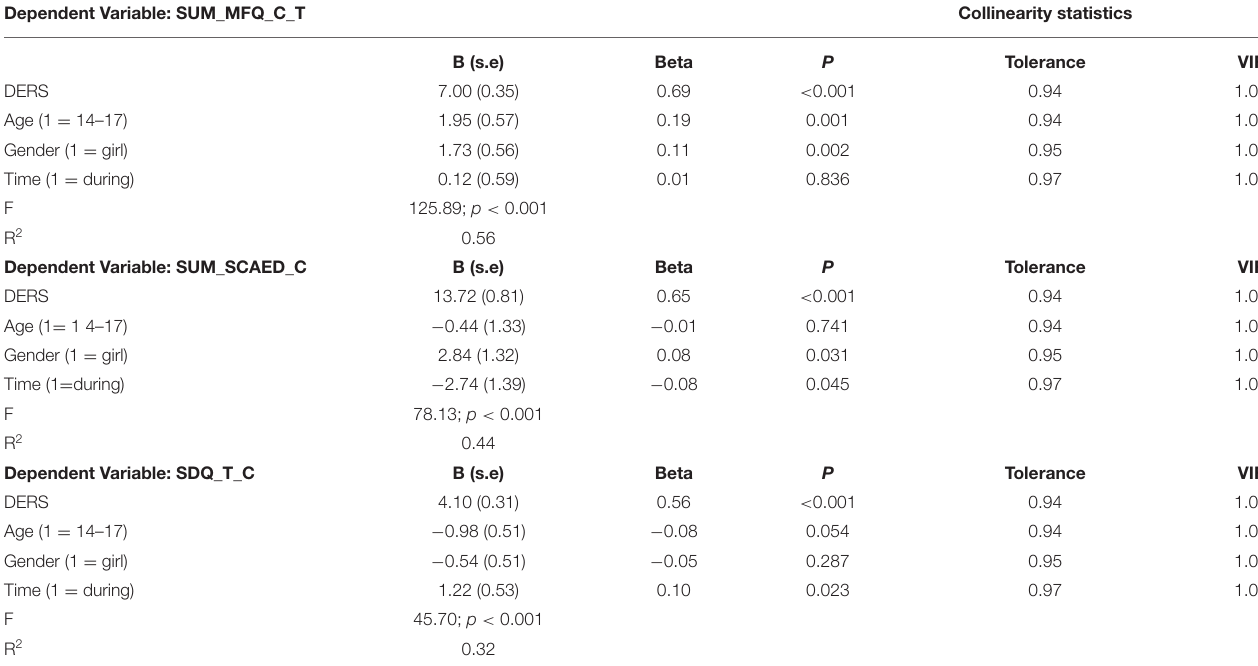
TABLE 6 | DERS impact on SMFQ-C, SDQ-t, SCARED measures stratified by age, gender, and time (before vs. during